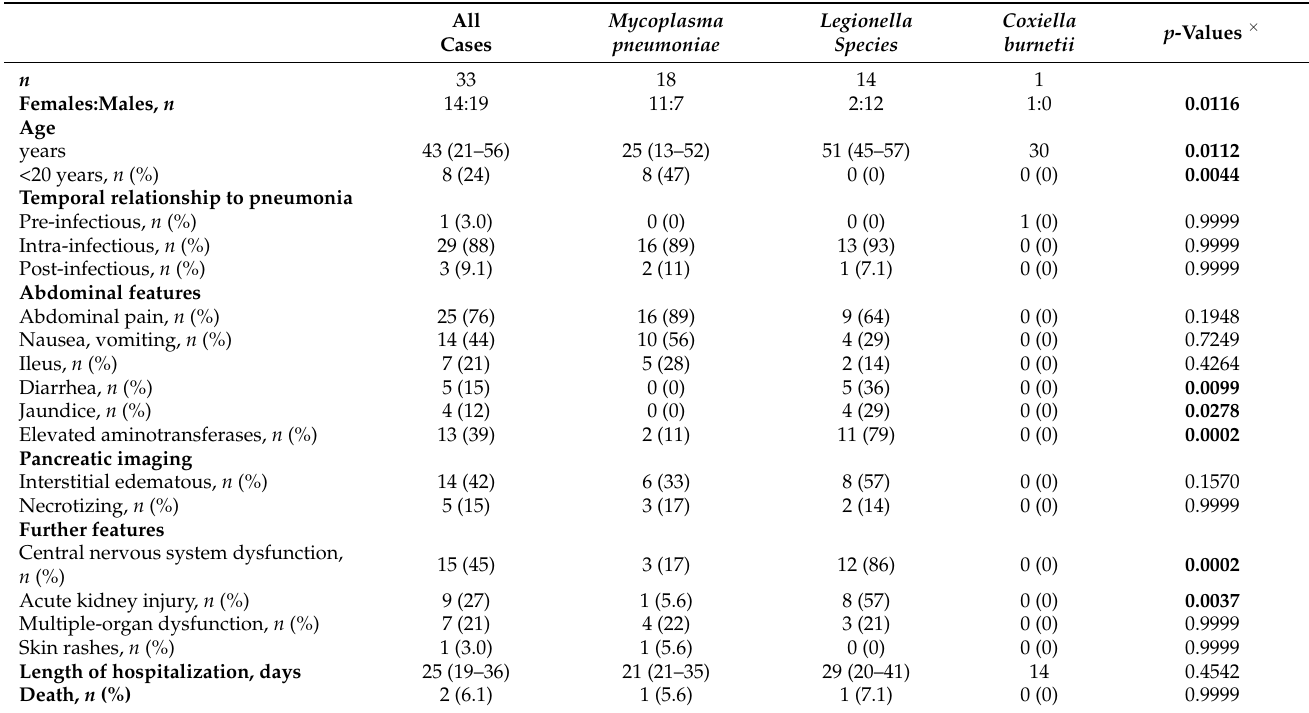
× Mycoplasma pneumoniae vs. Legionella